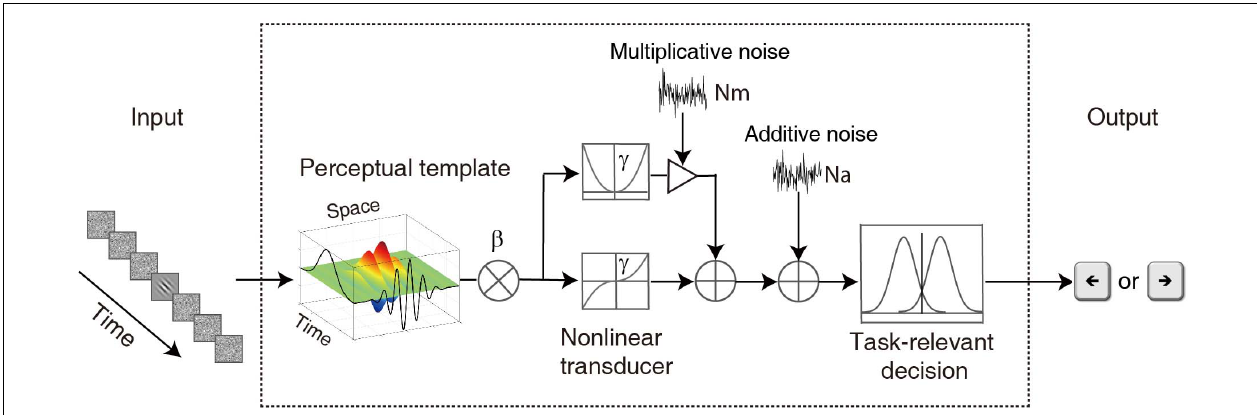
FIGURE 2 | A diagram of the elaborated perceptual template model (ePTM). The visual information first passes through a perceptual template. The perceptual template has a total signal gain of β . It also has different weight at different time. After the template matching, the information goes through a non-linear transducer with an exponent of γ , then gets contaminated by an internal additive noise Na and a multiplicative noise Nm , and finally is sent to the decision unit. The temporal weights at different SOAs can be inferred from the masking effects at different target-mask SOA